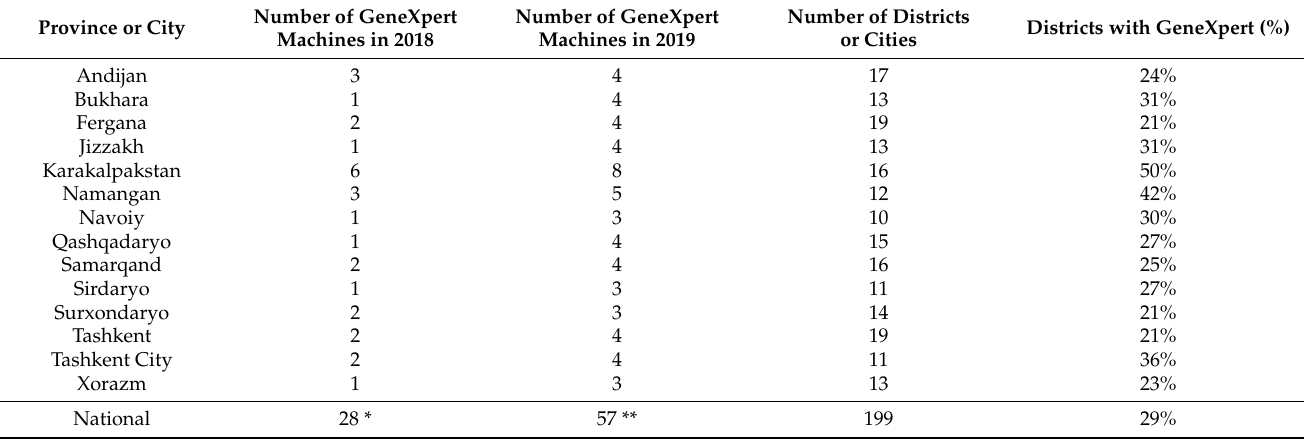
Table 1. Availability of GeneXpert machines in health facilities of Uzbekistan in 2018 and